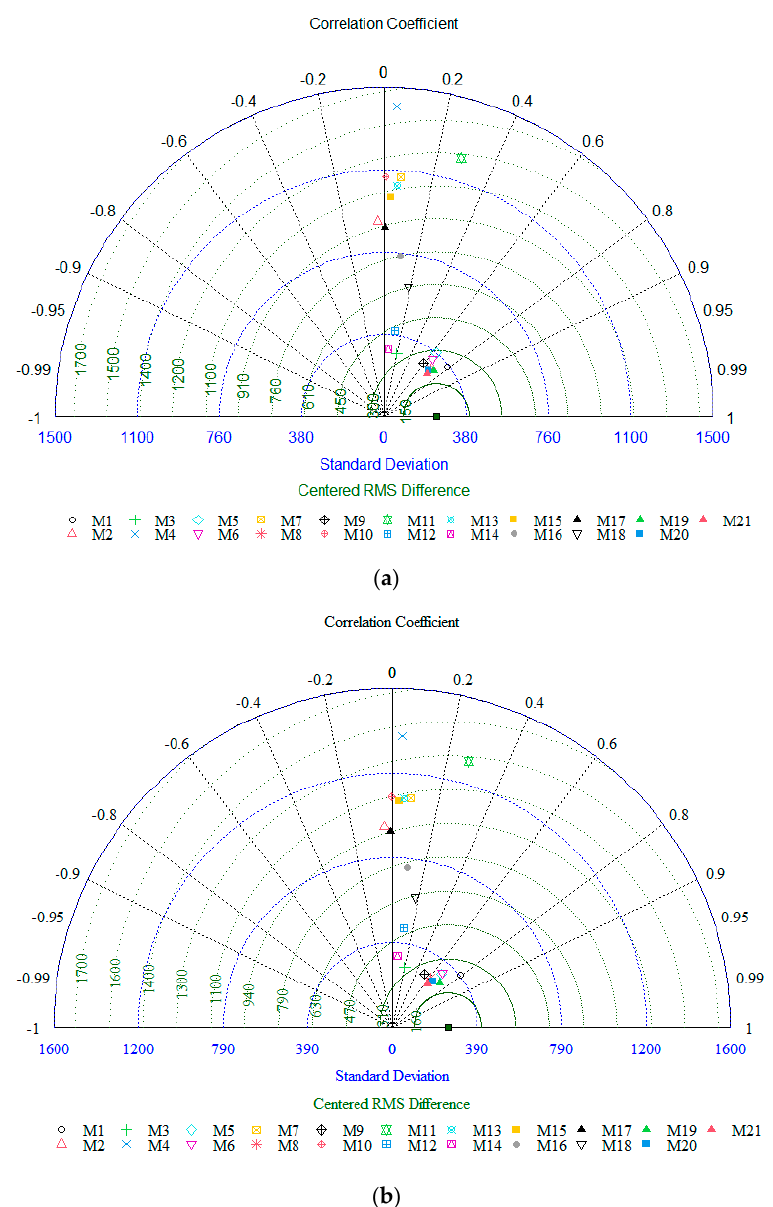
Figure 11. Grid-based comparison result for all climate models (including ensembles) using CRU reanalysis rainfall data as reference and for the historical period (1986–2016) in ( a ) and validation period (2006–2016) in ( b ).